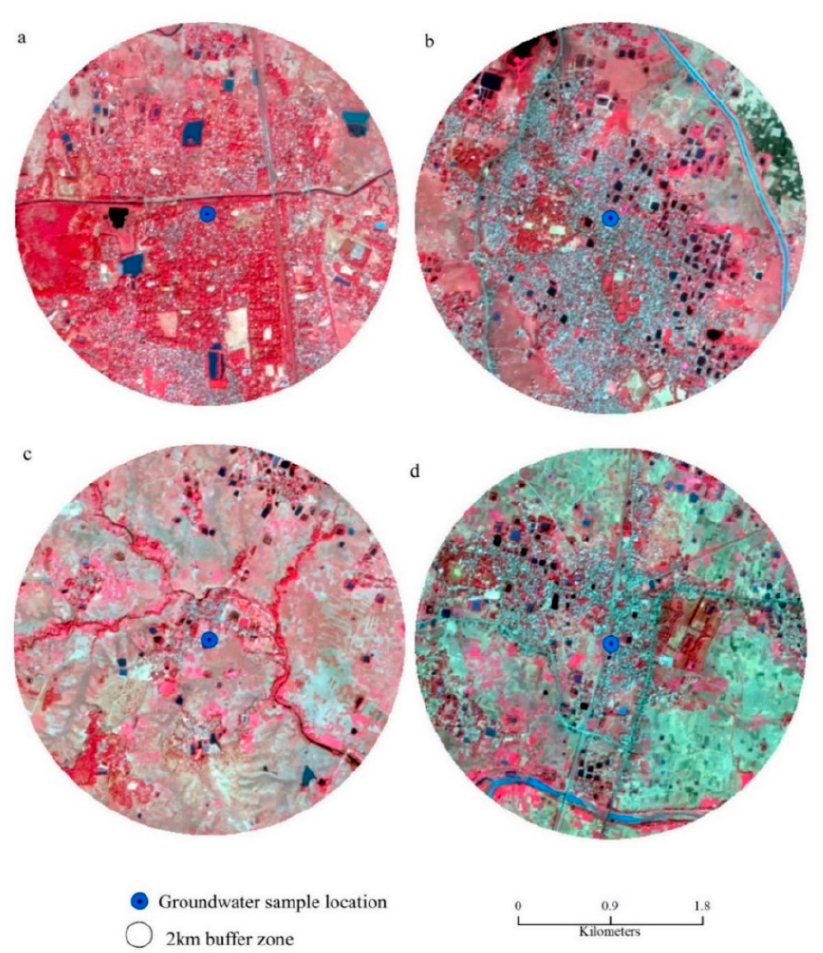
Figure 9. LULC of surrounding areas of the source of groundwater: ( a ) Bolpur, ( b ) Suri, ( c ) Bakreshwar, ( d ) Nalhati.